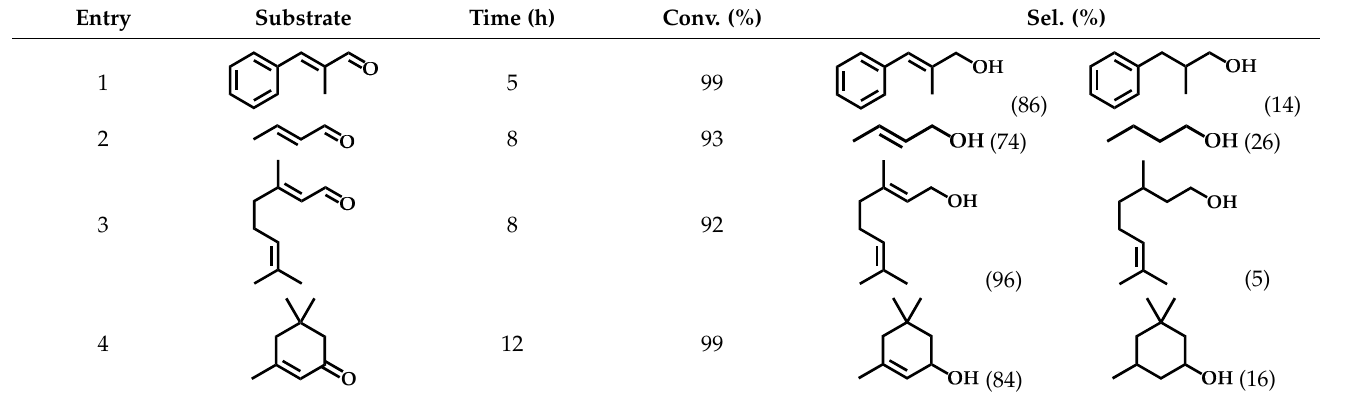
Table 4. Hydrogenation of various α , β -unsaturated aldehydes over the Co 1 Re 1 /TiO 2 catalyst.